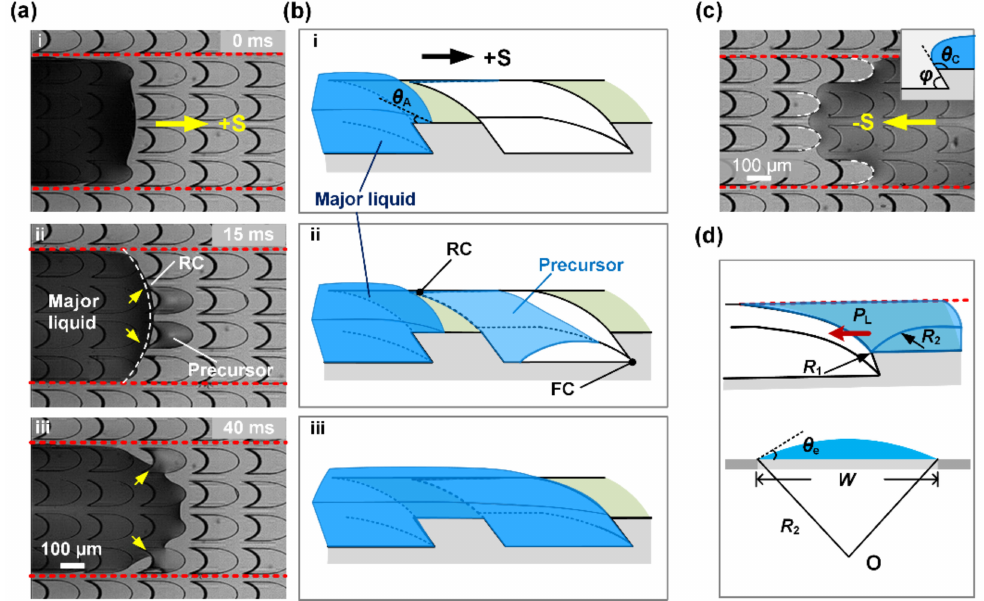
Figure4. ( a )Time-dependentmicroscopicpropagationbehaviorofliquidadvancingedge. ( b )Schematic depiction of the liquid forward flow. θ A is the advancing angle. rear corner (RC) and front corner (FC) represent rear corner and front corner of microcavity, respectively. ( c ) Morphology of liquid film on the stage in -S direction. θ C is the critical contact angle at which the liquid di ff uses downward along the arc-shaped edge. ( d ) Schematic drawing of the 3D morphology of liquid rear side. P L is the Laplace pressure of liquid surface. R 1 and R 2 are the radii of curvature of liquid film in horizontal and vertical section, respectively. θ e is the intrinsic contact